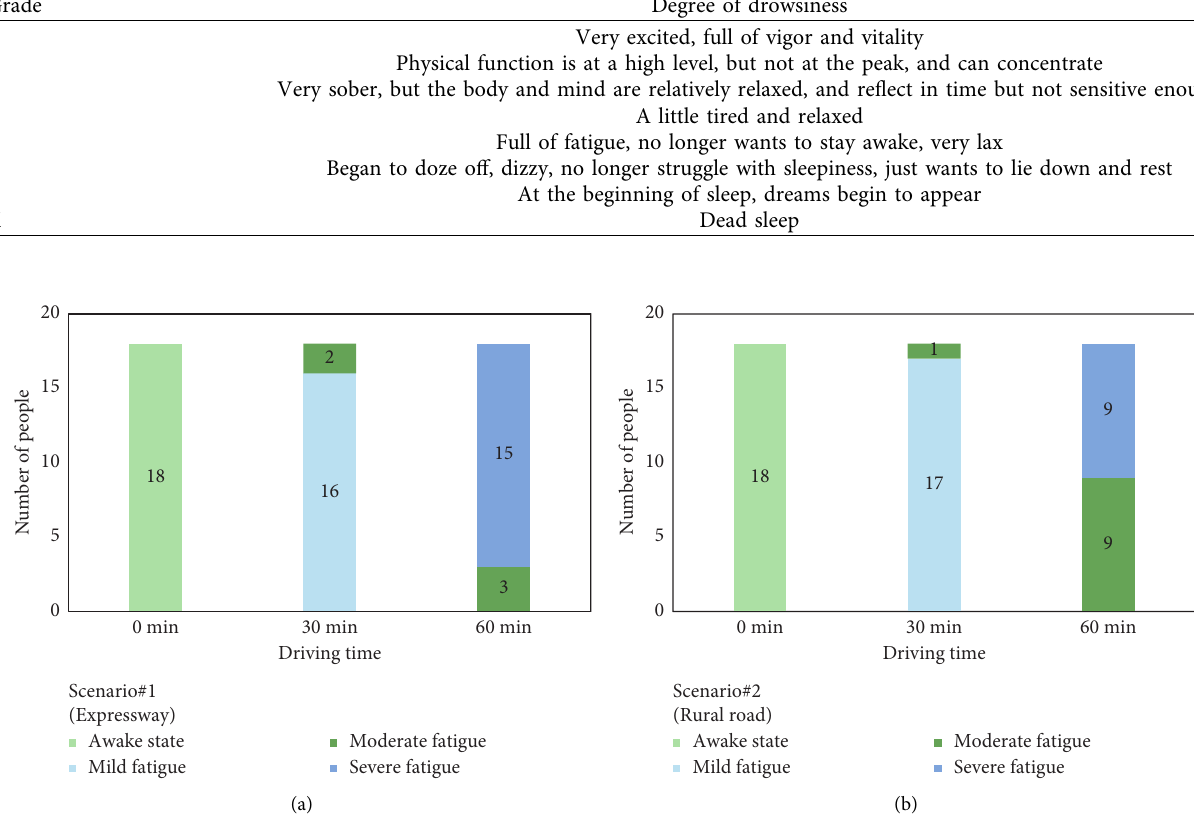
Figure 5: Drivers’ subjective fatigue degree. (a) Scenario#1. (b) Scenario#2.